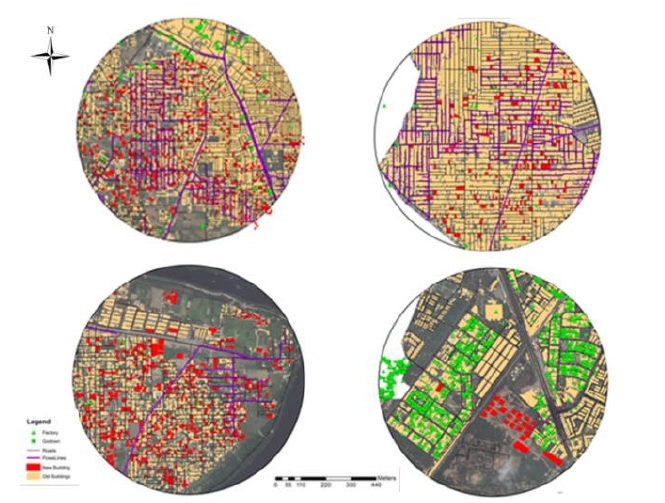
Figure 9: Urban Expansion